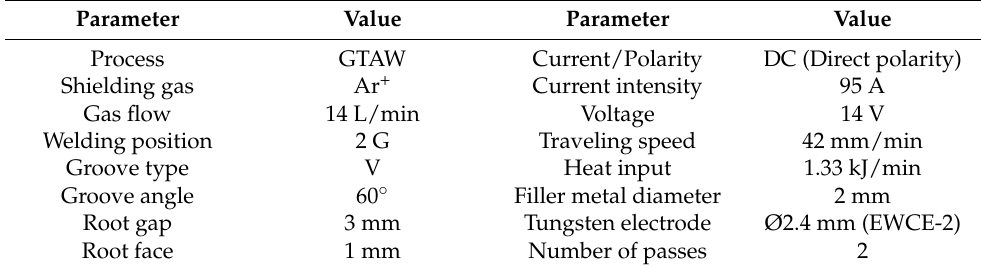
Table 4. Main parameters used in the welding